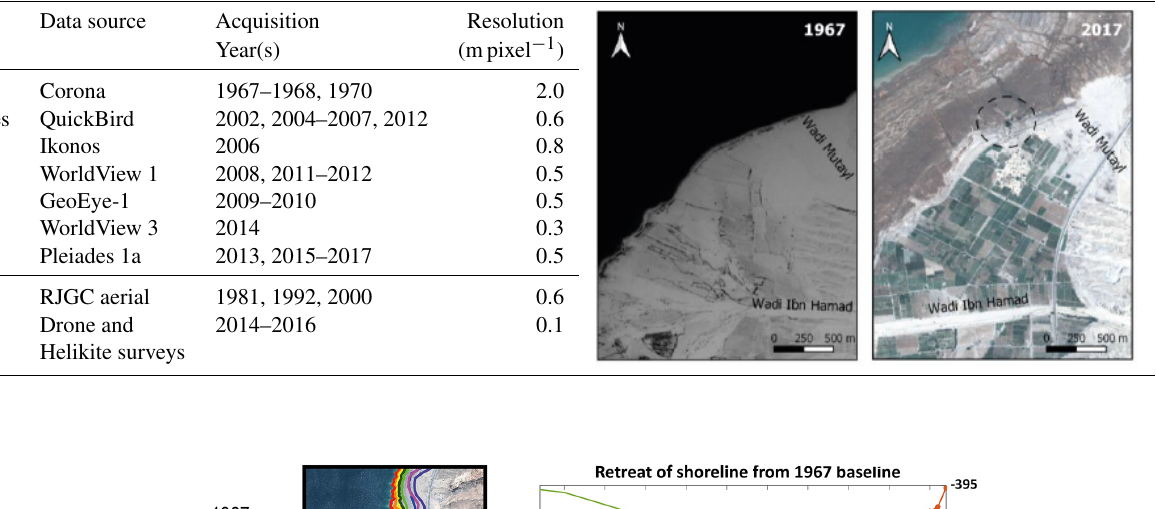
Table 1. Sources and resolution of remote- and near-sensing data used in this study. RJGC is the Royal Jordanian Geographic Centre. The spatial resolution of the dataset varies from 1.8 to 0.1m per pixel. The temporal resolution of the dataset is decadal from 1970 to 2010, and annual from 2004 to 2017. On the right are images of the southern part of the study area from 1967 and 2017 demonstrating the evolution of geomorphology and land use change in the study area. Dashed black ellipse marks the site of the former Numeira Mud Factory.